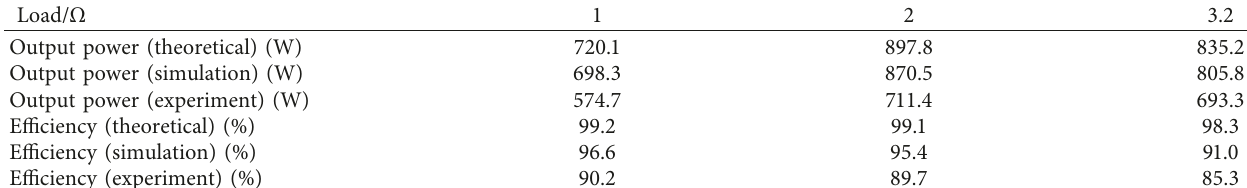
Figure 14: Coupling coil voltage and current waveform of the coupling mechanism at load 2 current waveform. (b) Secondary coil voltage waveform and current waveform. Table 7: Output of the system under different load parameters.